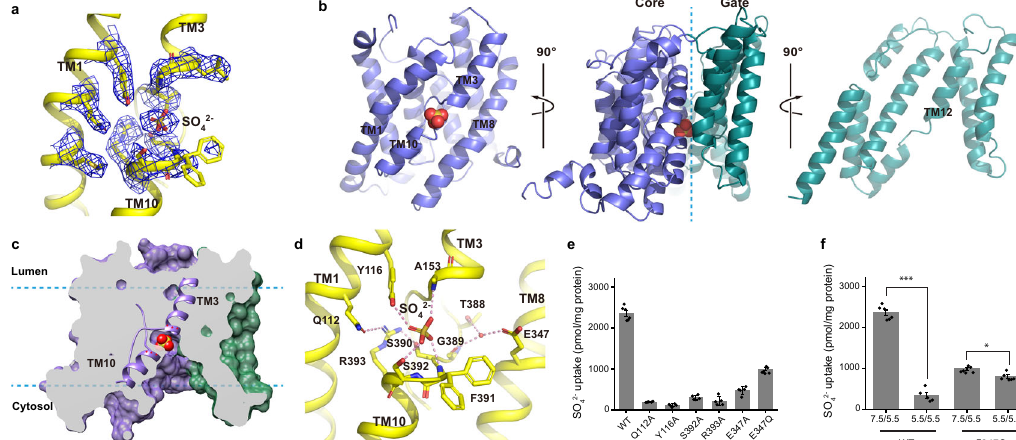
Fig. 3 AtSULTR4;1 substrate binding site. a Density of the bound SO 4 2 − and of residues nearby. Residues and SO 4 2 − are shown as sticks and the density is shown as blue mesh. b Cut-open view of the core and gate domains (violet and teal, respectively) of the TM domain of AtSULTR4;1. The two domains are rotated 90 o as indicated to reveal their contact surface and the substrate-binding site in the core domain (left). c Cutaway view of the TM domain. Violet and teal surfaces indicate the core and gate domains, respectively. TM3 and TM10 are highlighted in cartoon representation. d Coordination of SO 4 2 − in the binding site. Direct interactions are marked with dashed lines. e Mutational studies of residues in the substrate-binding site. f pH dependence of AtSULTR4;1 WT and E347Q mutant. The pH in /pH out conditions for each test are marked below the columns. The height of the columns represents the average of 5 – 6 repeats from 2 batches of liposomes independently prepared. n = 5 for Q112A, Y116A, S392A, E347A, and WT 5.5/5.5, and n = 6 for all others. Error bars indicate s.e.m. of the average. A two-tailed Student ’ s t test was applied to selected data. *** indicates p < 0.0001; * indicates p < 0.01. Exact p values can be found in the Source Data fi